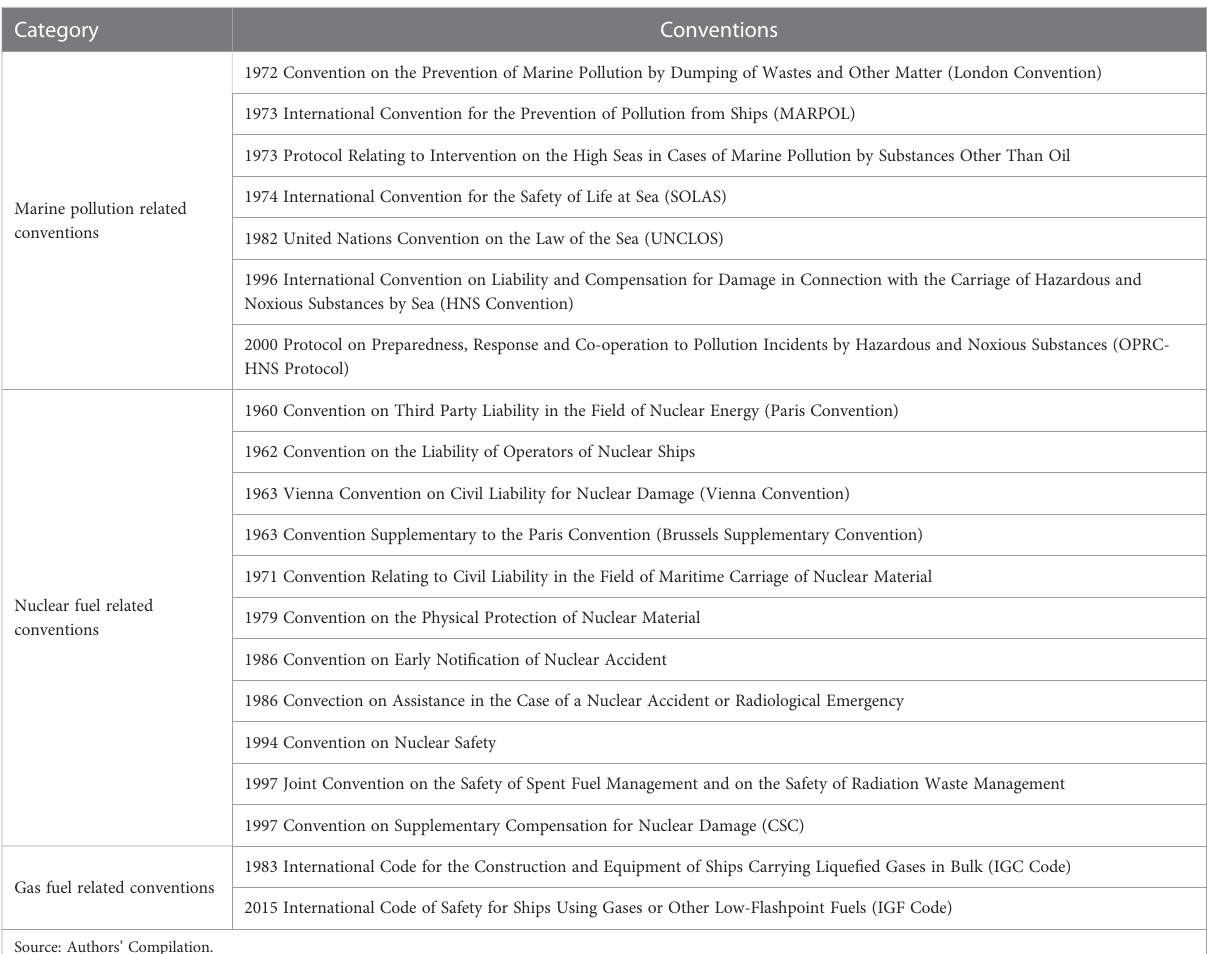
TABLE 1 Alternative fuels and energy-related international conventions, protocols, and